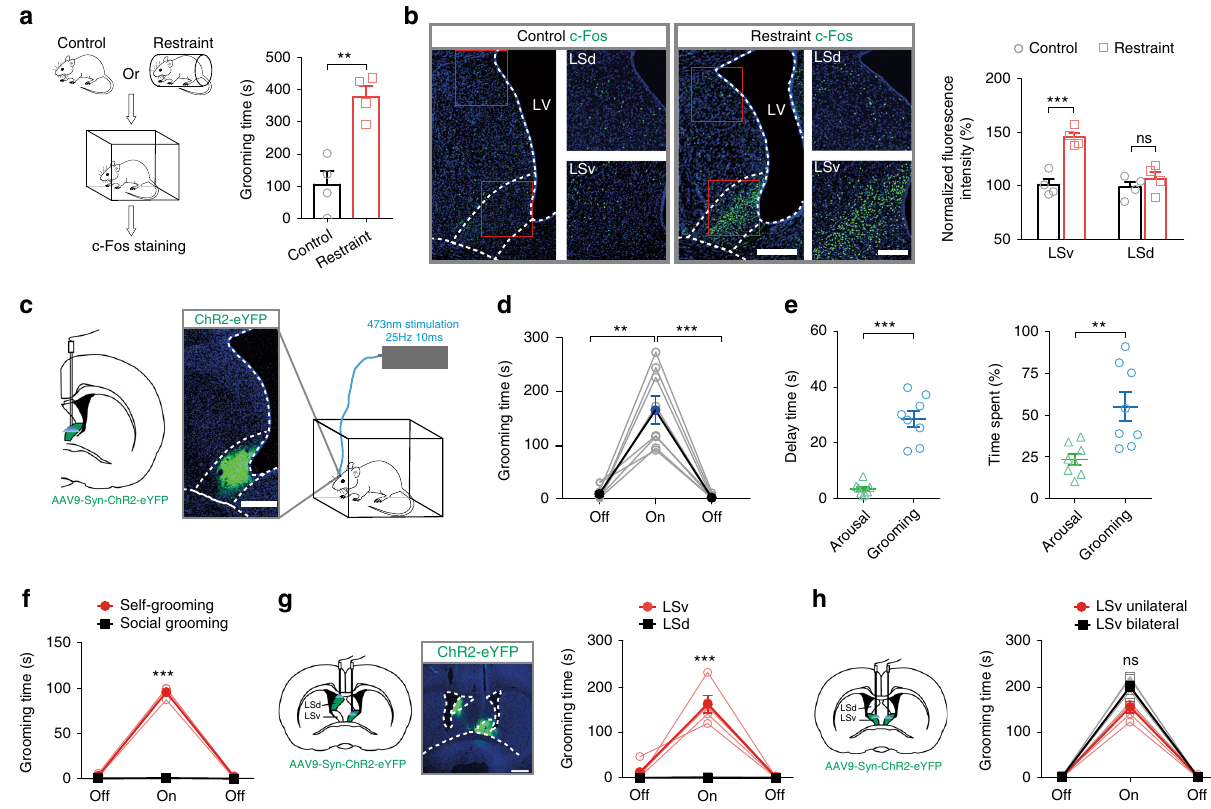
Fig. 1 Activation of ventral subdivision of LS triggers delayed but robust grooming behaviour. a Body restraint imposed on rats for 20 min induced signi fi cantly increased grooming behaviour within 10 min compared with control, before sacrí fi ce for c-Fos staining. n = 4; ** P = 0.0024; Student ’ s unpaired two-tailed t -test. b Representative c-Fos staining revealing activation of neurons in LSv but not LSd following body restraint stress. Magni fi ed LSd and LSv regions (red squares) are shown on the right. Scale bar, 500 μ m (left), 200 μ m (right). c Optogenetic activation of LSv by targeting an optic fi bre at unilateral LSv that expressed ChR2-eYFP after injection with AAV9-hSyn-hChR2(H134R)-eYFP. Scale bar 500 μ m. d A 5-min off + 5-min on + 5-min off optogenetic activation paradigm showed that activation of LSv neurons induced increased time spent in grooming behaviour ( n = 8, One-way repeated measures ANOVA with Tukey post-hoc test, pre-off vs. on, ** P = 0.0019; on vs. post-off, *** P = 0.0008). e Comparison of the delay and time spent in grooming and arousal behaviours, including rearing and heading, in the initial 2 min of LSv stimulation. Delay time, *** P < 0.0001; Time spent, ** P = 0.0041; Student ’ s paired two-tailed t -test. f LSv optogenetic stimulation only induced self-grooming but not social grooming in the rat (comparison during light on period between the two behaviours: n = 3, Student ’ s paired two-tailed t -test, *** P < 0.0001). g Left panel: implantation of optic fi bres targeting LSd and LSv in contralateral sides of the brain that expressed ChR2-eYFP. Right panel: only blue light stimulation of LSv ( n = 4) but not LSd ( n = 4) resulted in increased time spent in grooming. Scale bar, 1000 μ m. (comparison during light on period between the two groups: Student ’ s paired two-tailed t -test, *** P < 0.0001). h No signi fi cant (ns) difference in the time spent in grooming between unilateral ( n = 5) and bilateral ( n = 4) LSv stimulation (comparison between the two groups during light on period: P = 0.0553, Student ’ s two-tailed t -test). All data are presented as mean ± SEM. See also Supplementary Table 1 for